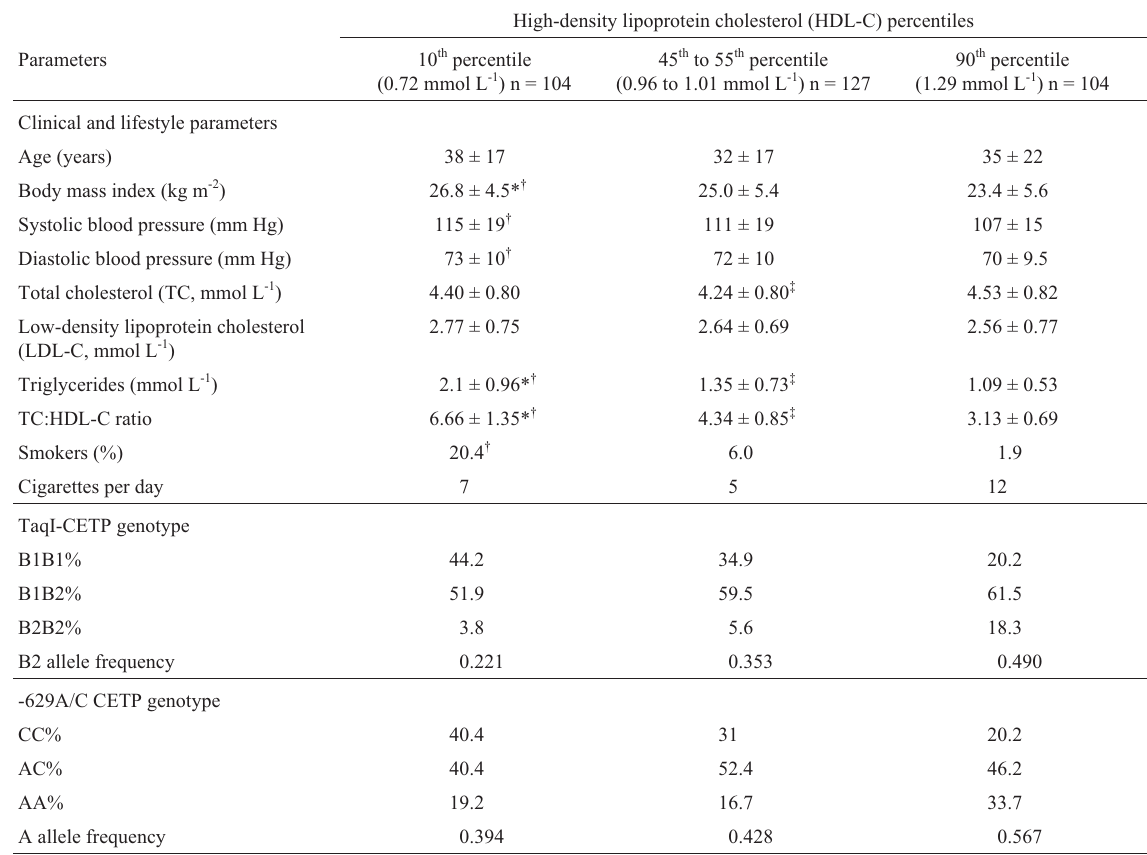
Table2 -Then=335populationsubsetclinicalandlifestyleparametersandcholesterolestertransferprotein(CETP)genotypes.Valuesare,asappropri- ate, means ± standard deviation or percentages for the total sub-set (males plus